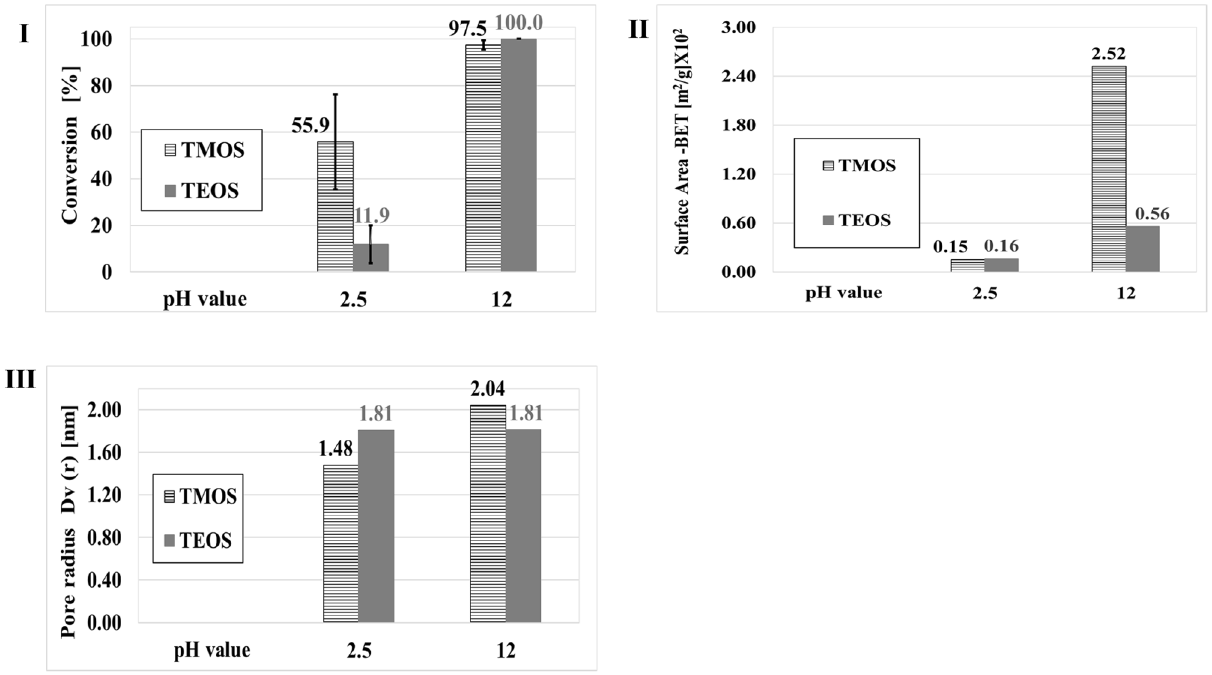
Figure 2. Effects of the pH of the matrices precursors solution on the conversion (I), surface area (II), and pore radii (III) of the matrices for the different precursors in the first cycle, in toluene. Sol–gel matrix was prepared with TMOS or TEOS at pH 2.5 or pH 12, Catalyst B (catalyst initial = 1.0 . 10 –6 mol). RCM of DDM reaction 1